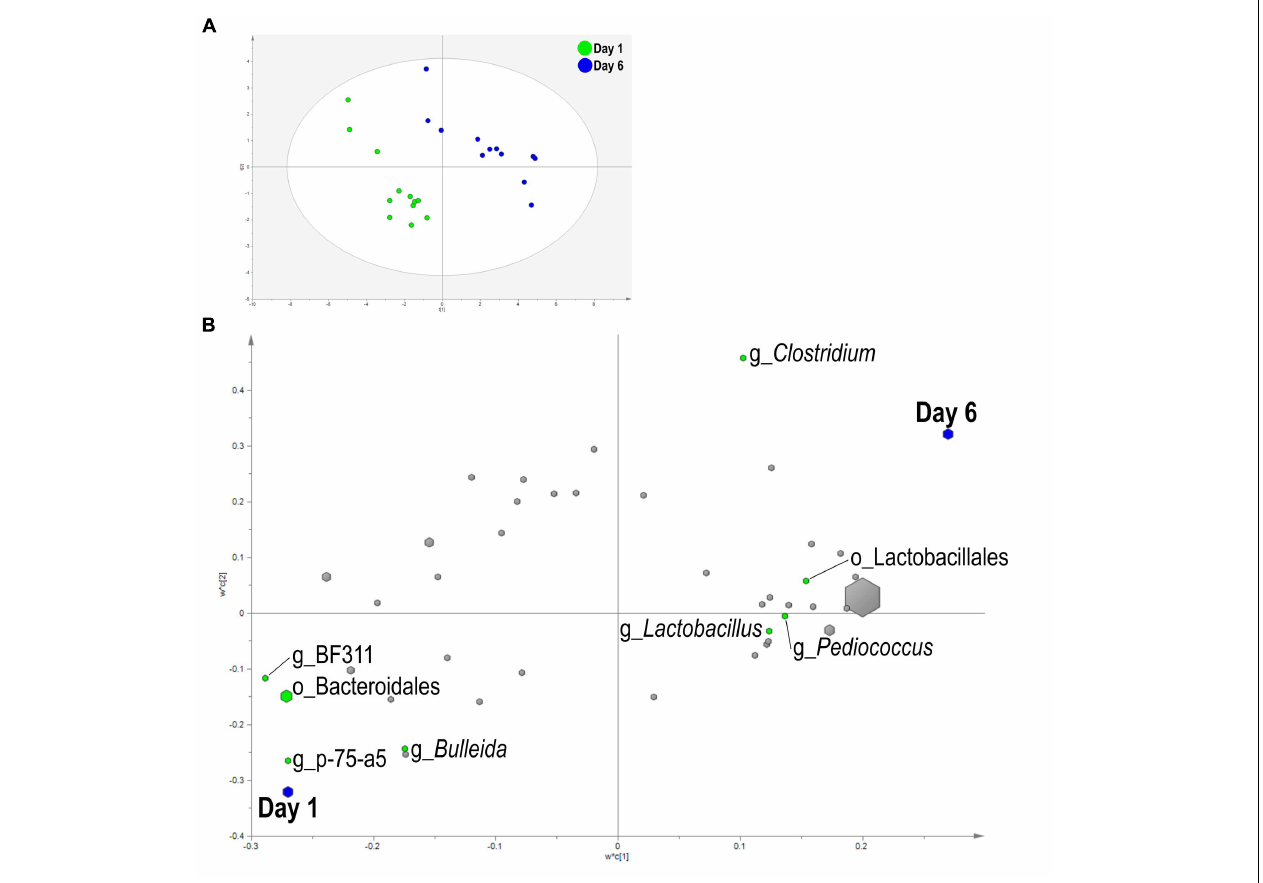
FIGURE 3 | Partial least squares discriminant analysis (PLS-DA) model of the liquid fraction bacterial communities with three components. (A) PLS-DA score scatter plot discriminating between day 1 and day 6 in the liquid fraction [goodness-of-fit parameter (R 2 ) (Y) = 0.97; predictive ability parameter (Q 2 ) (cum) = 0.66] with each point representing a single sample. (B) PLS-DA loading scatter plot of bacteria classified to the lowest taxonomic level. Taxa with significant coefficient values (relationship between X and Y variables) are labeled. The size of each point corresponds to the average relative abundance of the taxa. Letter prefix denotes the lowest level of taxonomic identification [genus (g) and order